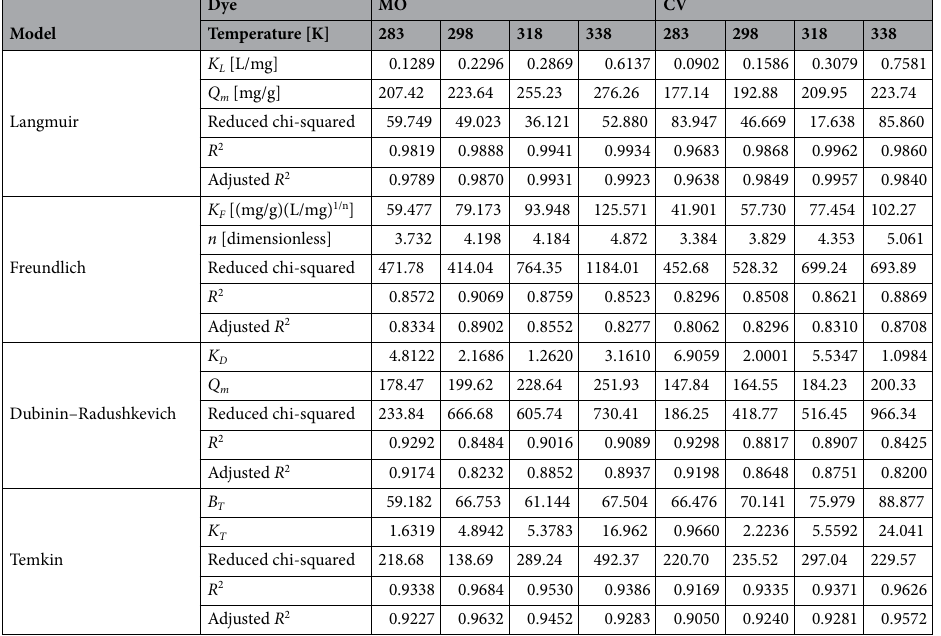
Table 1. Fitting parameters obtained from isotherm models for the MO and CV adsorption onto the Fe 3 O 4 @ inulin